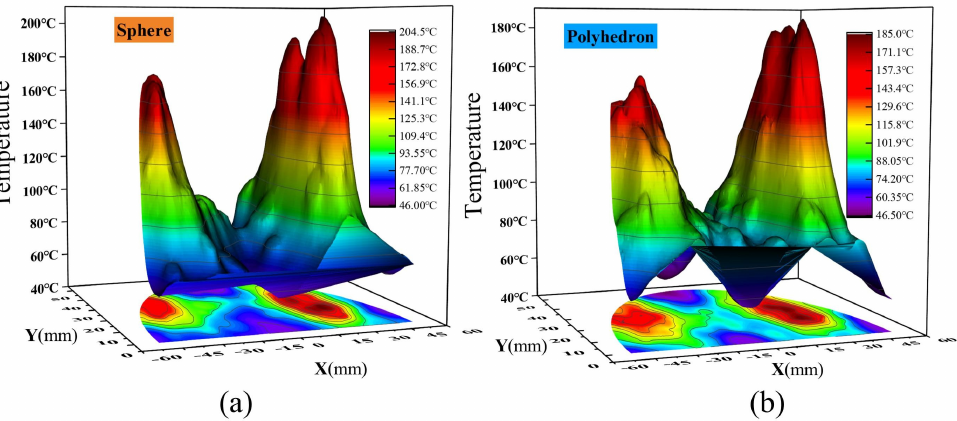
Figure 5. The temperature distributions in the center slice of spherical aggregate ( a ) and polyhedral aggregate ( b ) after microwave heating for 40 s.